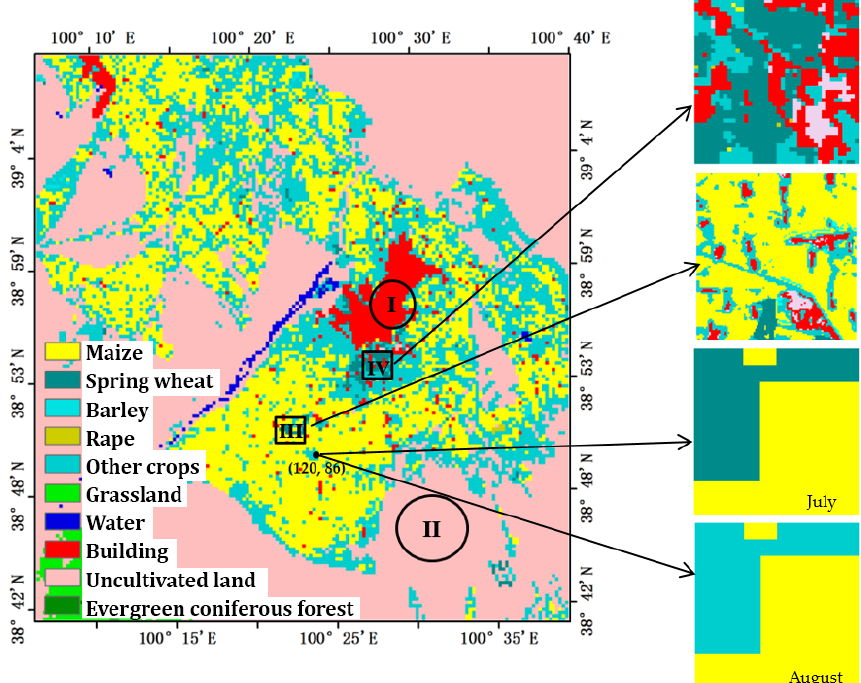
Figure 7. Land cover maps of the study area at 300m resolution and certain regions at 30m resolution. Area I and II represent the area of pure pixels, Area III and IV represent the area of mixed pixels, and (120, 86) represents an example point of different land cover types in different